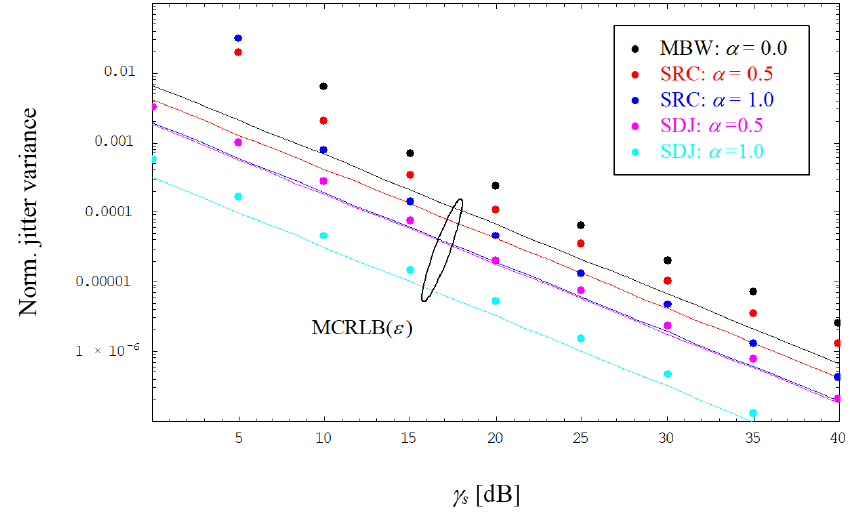
Figure 6. Normalized jitter variance for timing estimates (FF receiver).